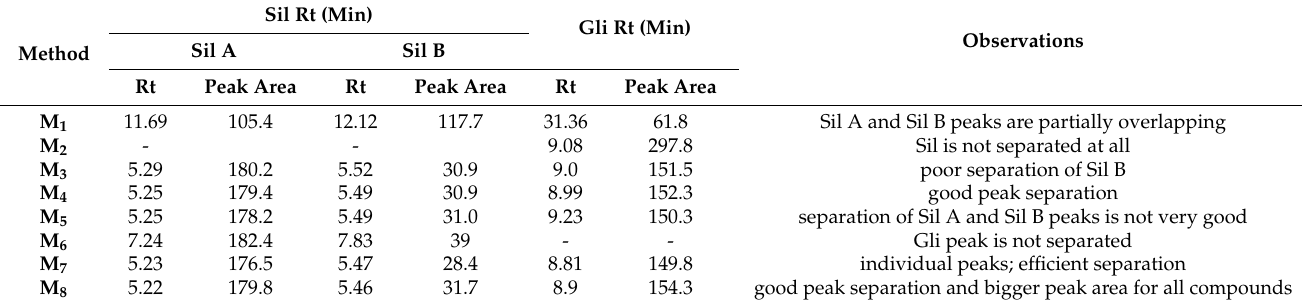
Table 2. The Rt and peak areas for studied compounds recorded for all methods (M 1 –M 8